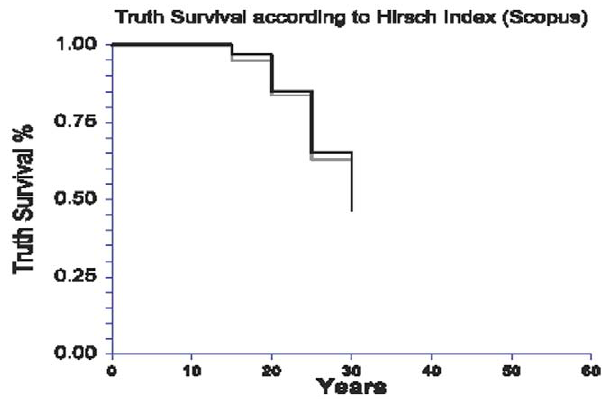
Figure 3. Survival of truth according to the Scopus Hirsch- index. Survival of 227 conclusions according to the h-index above of the median value=16, using the Scopus data-base from 1995 to 2009. There was no significant difference between 50 years survival, 53 6 8% (black line) and 48 6 9% (grey line), respectively (P=0.63).